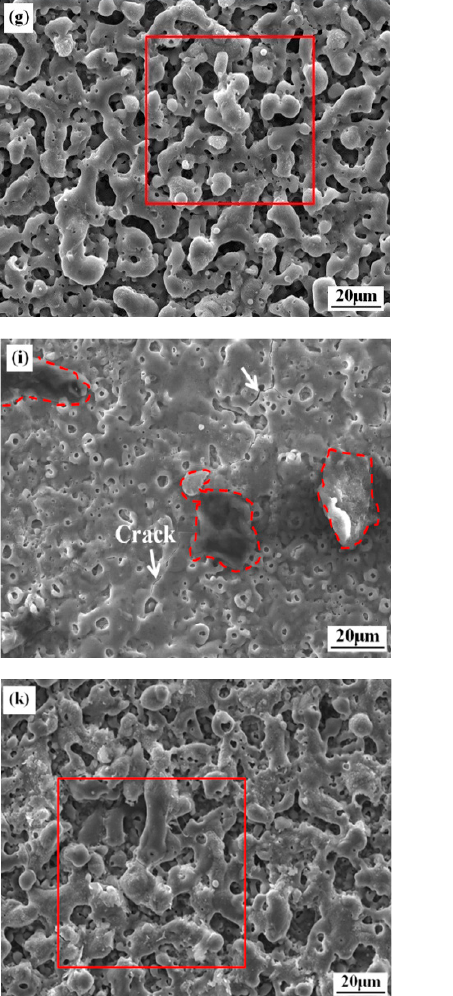
Figure 2. Surface morphologies of the coatings with different concentrations of graphene: ( a , b ) G0, ( c , d ) G1, ( e , f ) G2, ( g , h ) G3, ( i , j ) G4, ( k , l ) G5; ( b , d , f , h , j,l ) the magnification morphologies of the graphs ( a , c , e , g , i , k ).